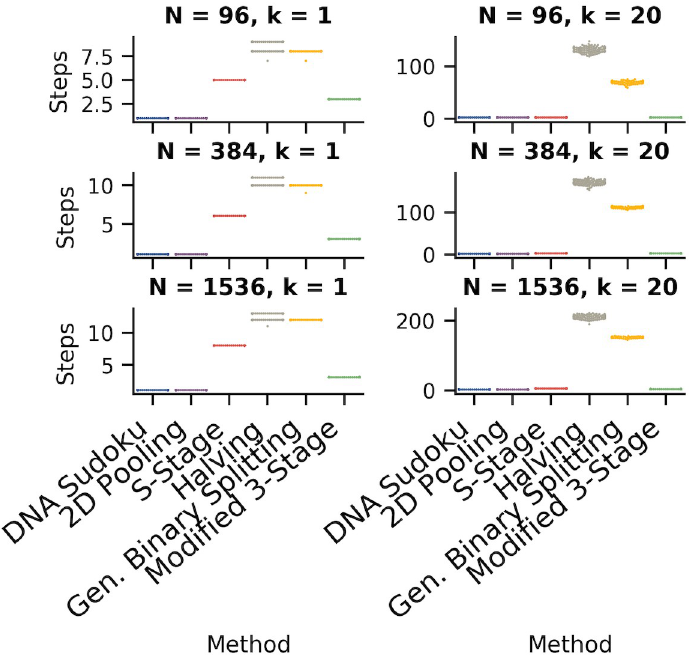
Fig 8. Comparison of the number of steps required for each pooling method. The swarm plots show the distribution of the number of steps required for each method (100 simulations each). The left column shows simulations with one positive sample and the right column shows simulations with 20 positive samples. The rows are different sample sizes from top to bottom: 96, 384, and 1,596. The results are from the same set of simulations as shown in Fig 7.